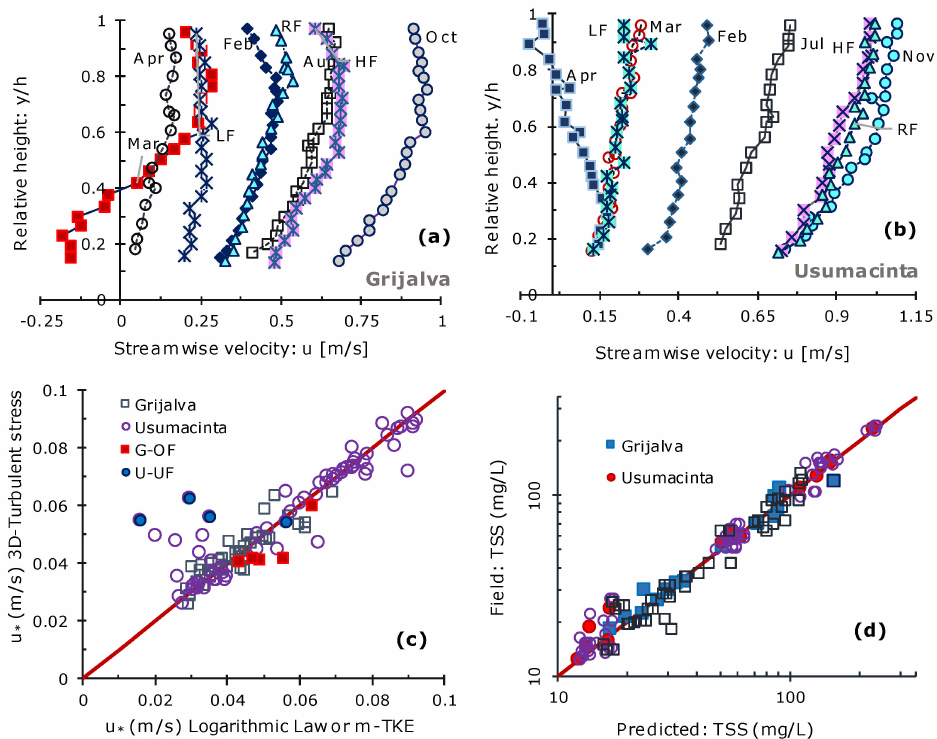
Figure 7. River hydrodynamics and method validation: ( a , b ) intra-annual variability in velocity profile; ( c ) comparison of shear velocities derived from 3D-turbulent stress and other methods; and ( d ) Total suspended solids (TSS) derived from fluid corrected backscatter (FCB) compared to those measured on the field. HF: High-flow (November 2021); LF: Low-flow (April 2022); RF: Raising-flow (August 2022). In panel ( c ), G-0F: Over flow event at the Grijalva (March 2017), U-UF: Under flow event at the Usumacinta (April 2017). In panel ( d ), filled markers: mean monthly TSS, empty markers: depth-averaged